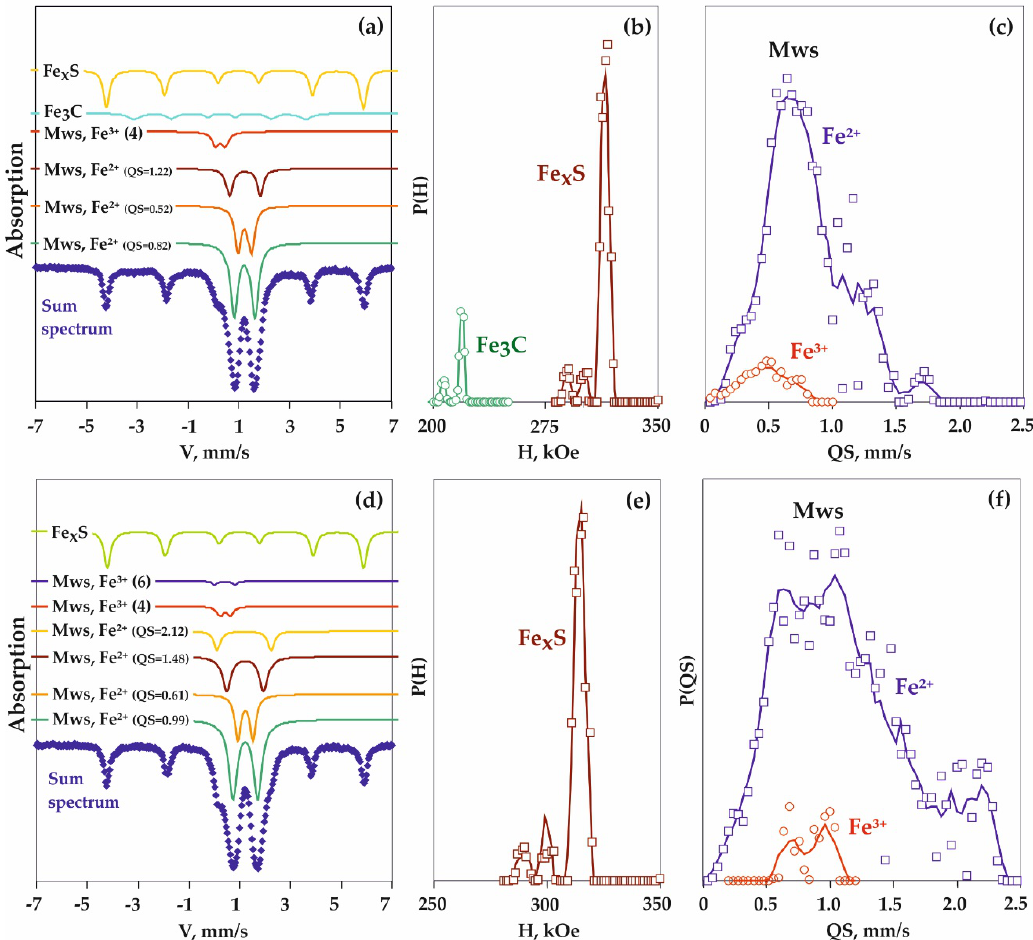
Figure 14. Mössbauer spectra of samples produced in the carbonate-iron-sulphur system (exp. 1623 ( a – c ) and 1620 ( d – f )) as well as components of these spectra ( a,d ), the probability distribution of hyperfine magnetic fields (H) on iron nuclei ( b,e ) and the probability distribution of quadrupole splittings P(QS) in experimental spectra of magnesiowüstite and silicates ( c,f ).